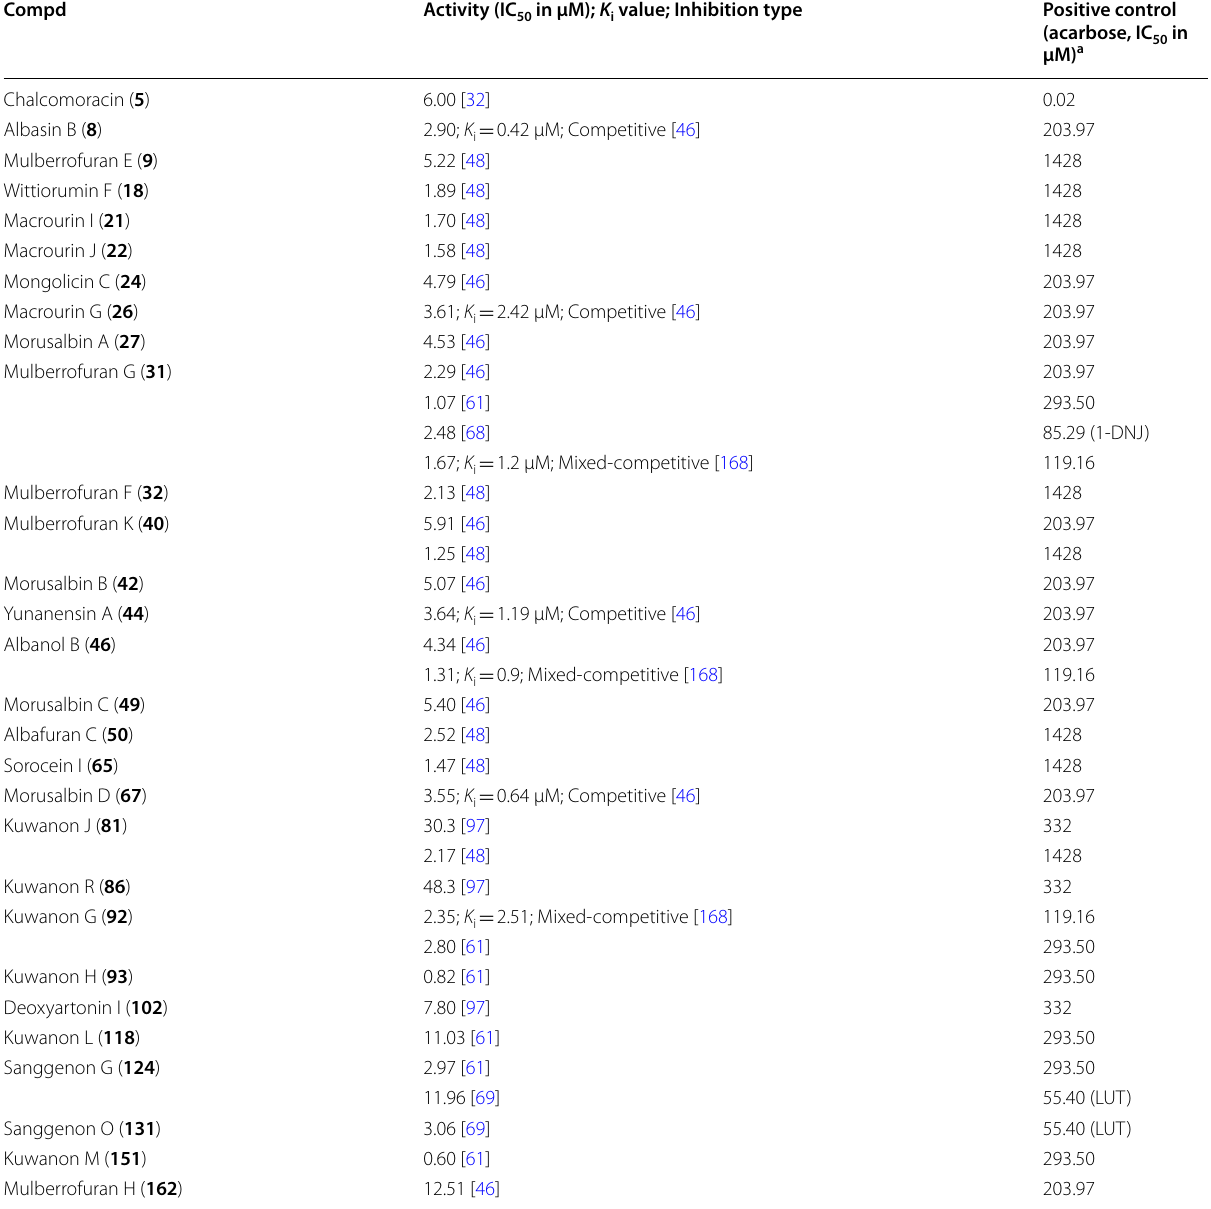
Table 7 Inhibitory activities of MDAAs against α ‑glucosidase